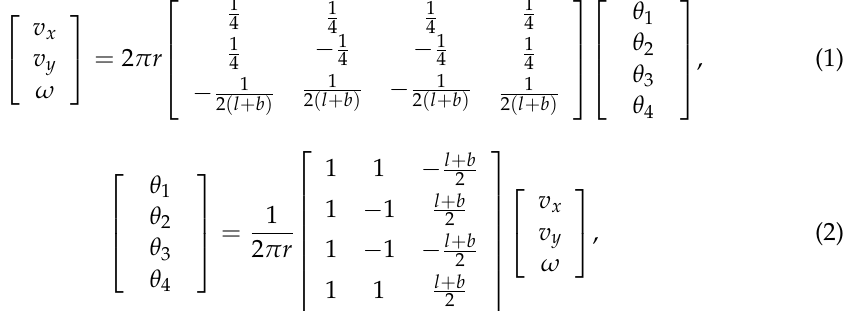
Figure 3. Omnidirectional chassis.